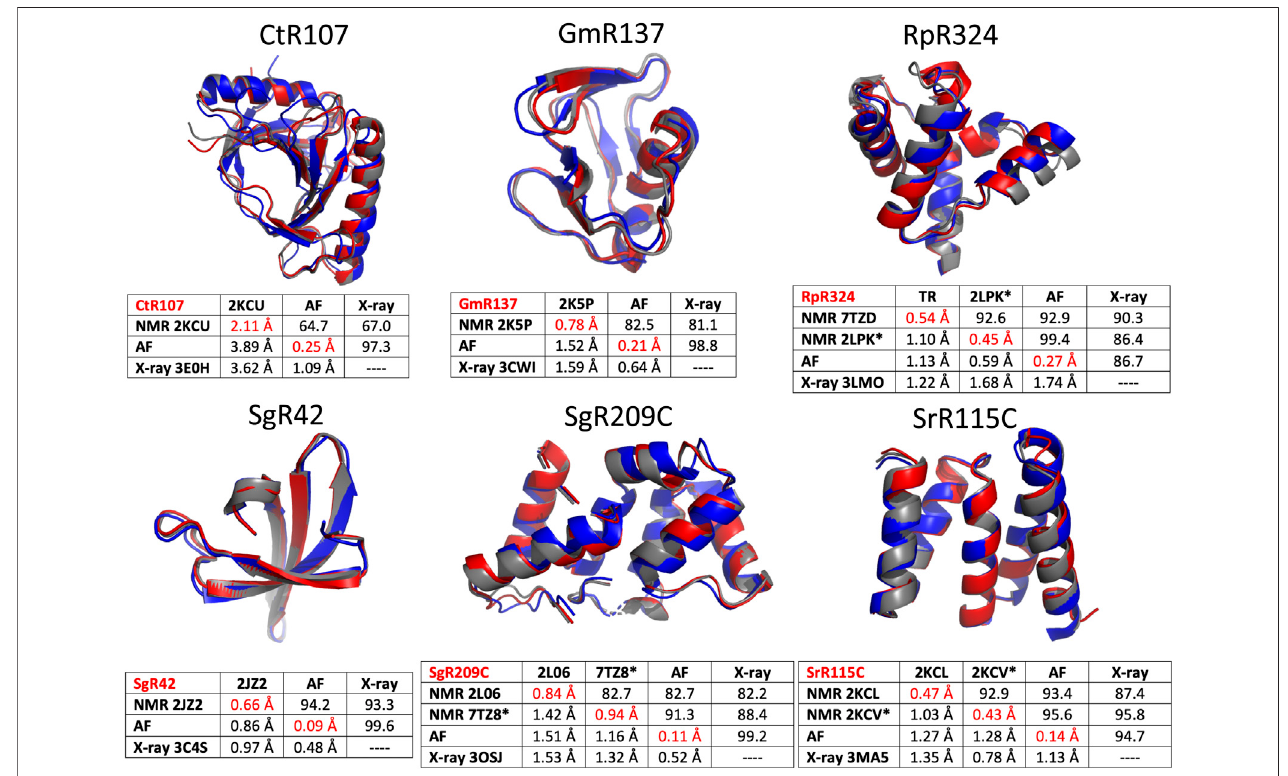
FIGURE5| ComparisonofAlphaFold,NMRandX-raycrystallographymodels.SuperimposedbackbonestructuresofsolutionNMRstructures(NMR,blue),X-ray crystal structures (X-ray, grey), and AlphaFold prediction models (AF, red) for six proteins selected from the NESG NMR/X-ray pairs database. Below each superimpositionisamatrixofbackbonestructurally-similaritystatistics.TheupperdiagonalprovidesGDT-TSscores,andthelowerdiagonalC α backboneRMSDs.The diagonals (with values in red) are C α RMSD ’ s within the corresponding superimposed conformer ensemble relative to the medoid conformer. These models are comparedonlyforresiduesthatareboth “ well-de fi ned ” intheNMRensembleand “ reliablypredicted ” intheAlphaFold models,asindicatedin Table1 .ForNMRandAF modelensembles,thecoordinatesofthemedoidconformersarecompared.ForNMRstructures re fi nedwithRDCdata(i.e.,targetsRpR324, SgR209C, andSrR115C) the image provided is for the medoid conformer of the structure determined with these RDC